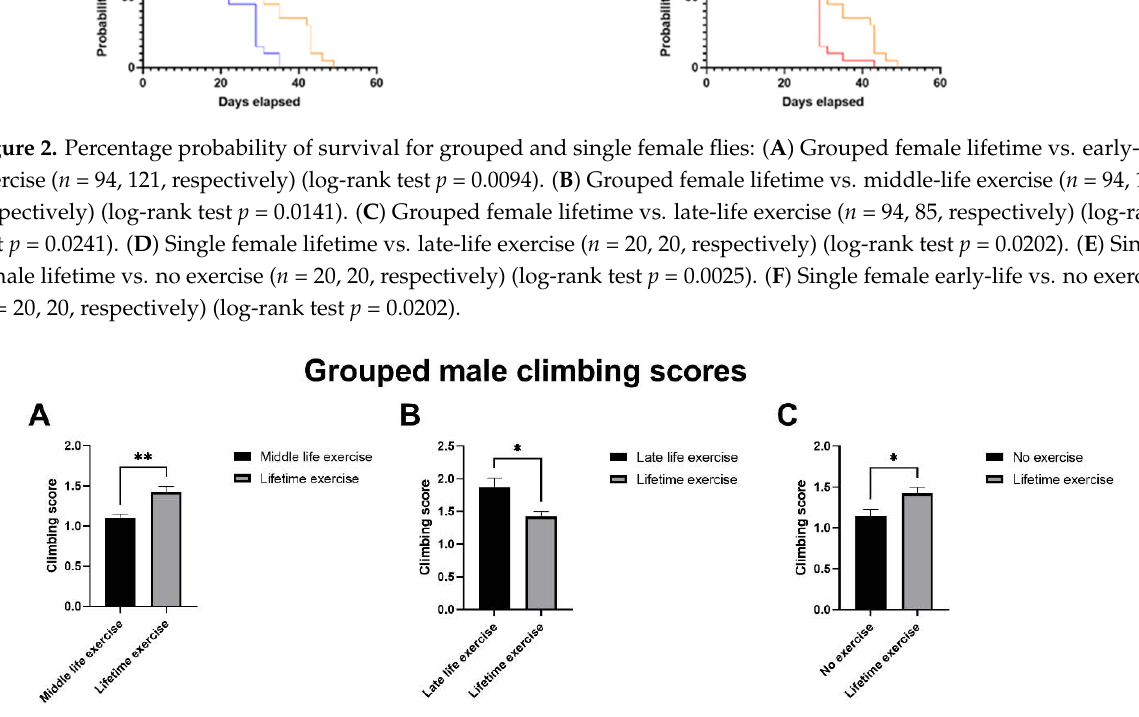
Figure 3. Grouped male Drosophila under different exercise regimens produced different climbing scores when compared with lifetime exercise: ( A ) Lifetime exercise vs. middle-life exercise ( n = 6) (unpaired t -test, p = 0.0051, ** = <0.01). ( B ) Lifetime exercise vs. late-life exercise ( n = 6) (unpaired t -test, p = 0.0183, * = < 0.05). ( C ) Lifetime exercise vs. no exercise ( n = 6) (unpaired t -test, p = 0.0344, * = < 0.05).